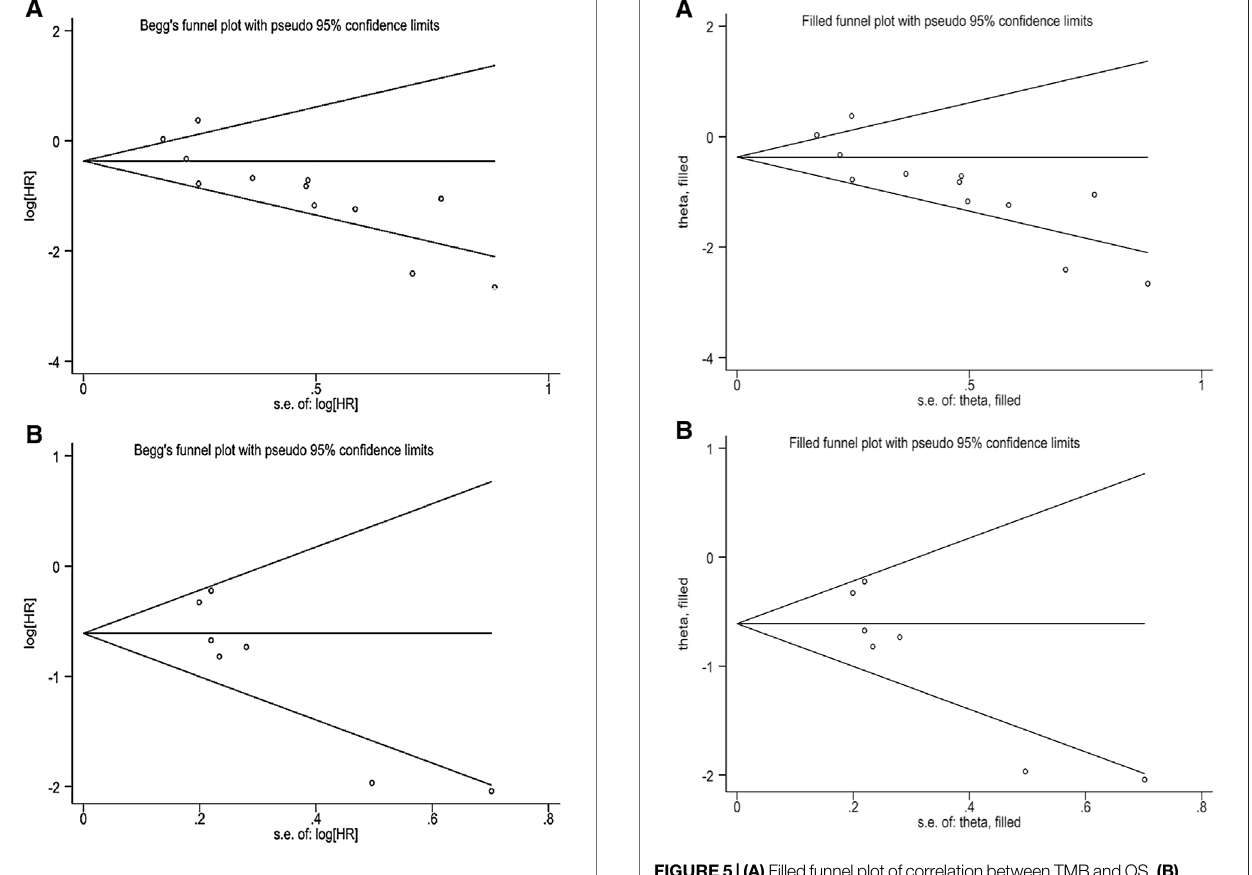
FIGURE 4 | (A) Begg ’ s funnel plot of correlation between TMB and OS. (B) Begg ’ s funnel plot of correlation between TMB and PFS.